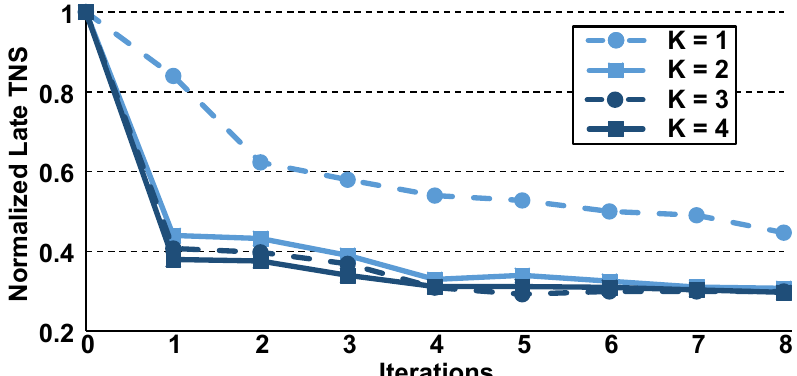
Figure 7. TNS comparison for different values of exponent K for LM initialization as proposed in Equations (5) and (6) for representative design, fft_fast. Higher values of K increase LMs of critical arcs leading to faster TNS improvement during optimization iterations. Beyond K = 2, there are not sufficient savings.